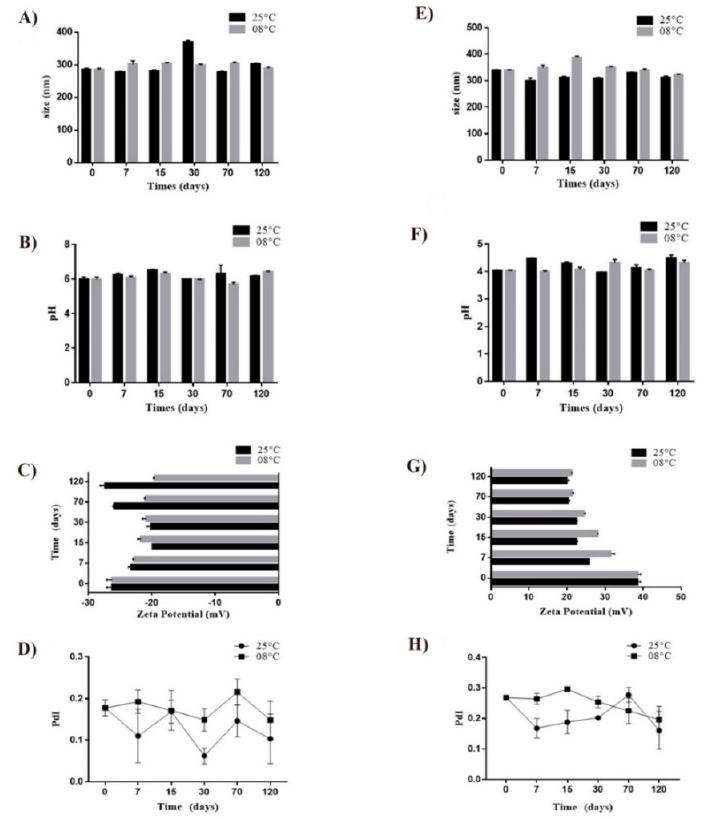
Figure 6. Evaluation of average size, pH, zeta potential, and PdI for NC ( A – D ) and NC-CH ( E – H ) stored at 8 ± 3.0 °C and 25 ± 2.0 °C, over 0, 7, 15, 30, 70, and 120 days.